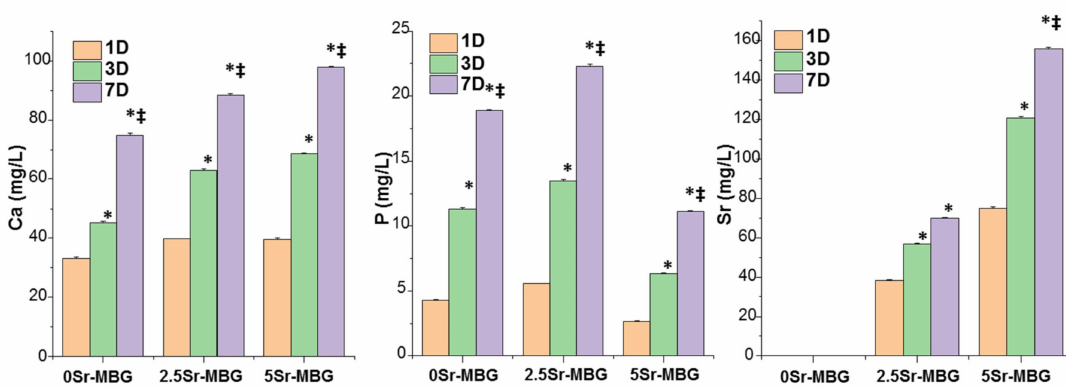
Figure 6. Cumulative release of ( A ) calcium, ( B ) phosphorous and ( C ) strontium, with the content of 0, 2.5, 5Sr-MBG disks, respectively, between 1 and 7 d in a complete medium. * Comparisons between each 0Sr-MBG and Sr-MBGs, ‡ comparisons between 2.5Sr-MBG and 5Sr-MBG. Statistical significance: * ‡ p <